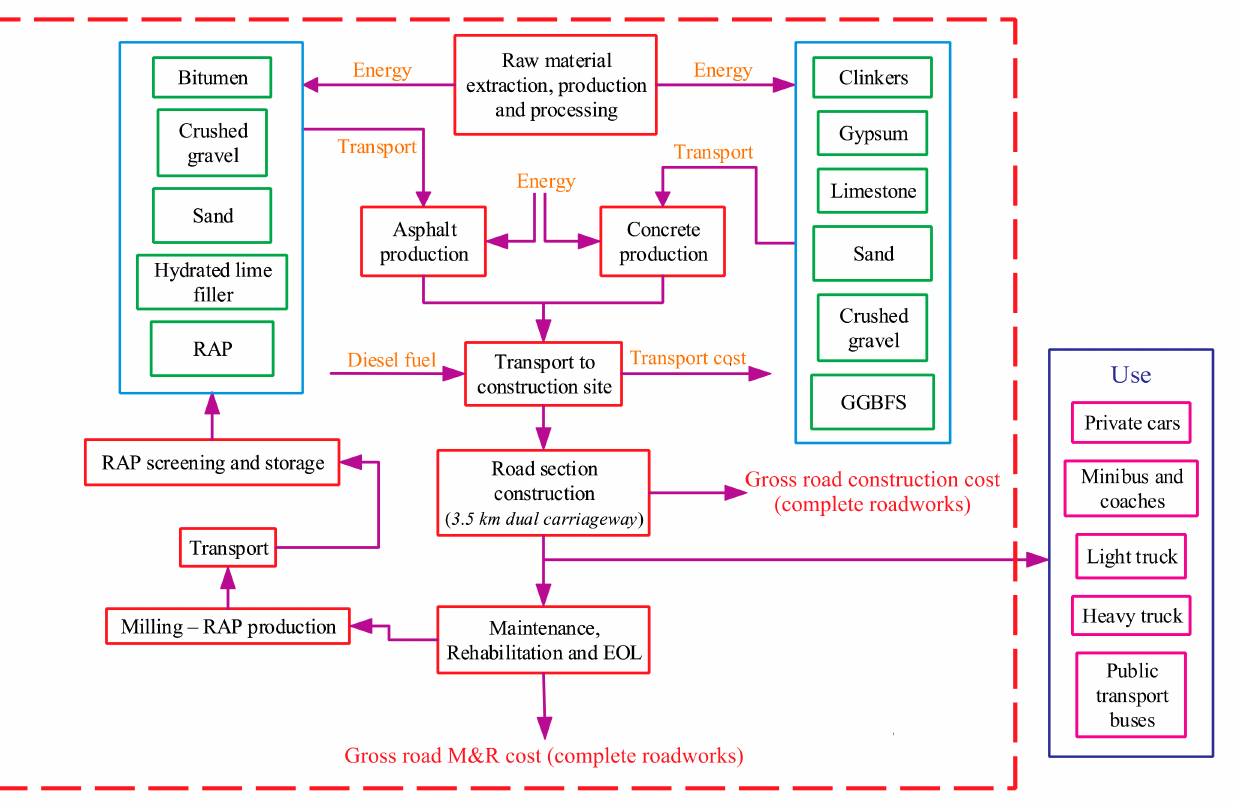
Figure 2. System boundary considered for the studied pavement